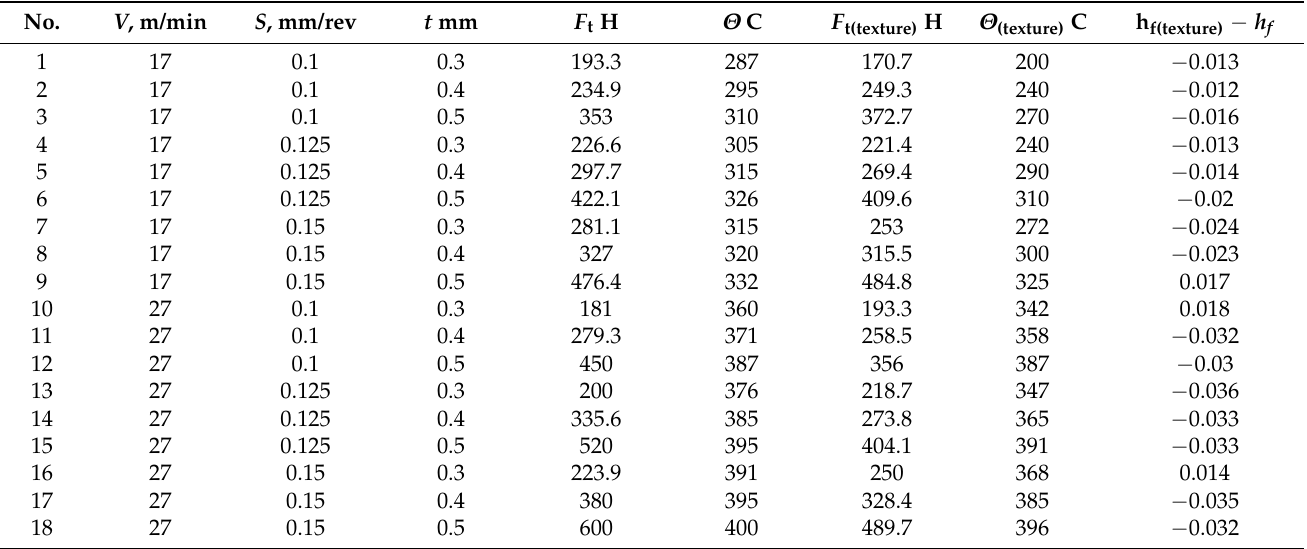
Table 1. Values of the studied processing parameters were obtained as a result of experiments for the original and textured